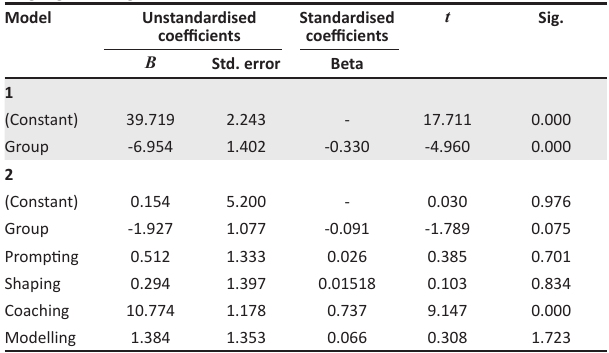
TABLE 7: Coefficient output: Behaviour modification practices and English language reading abilities. Model